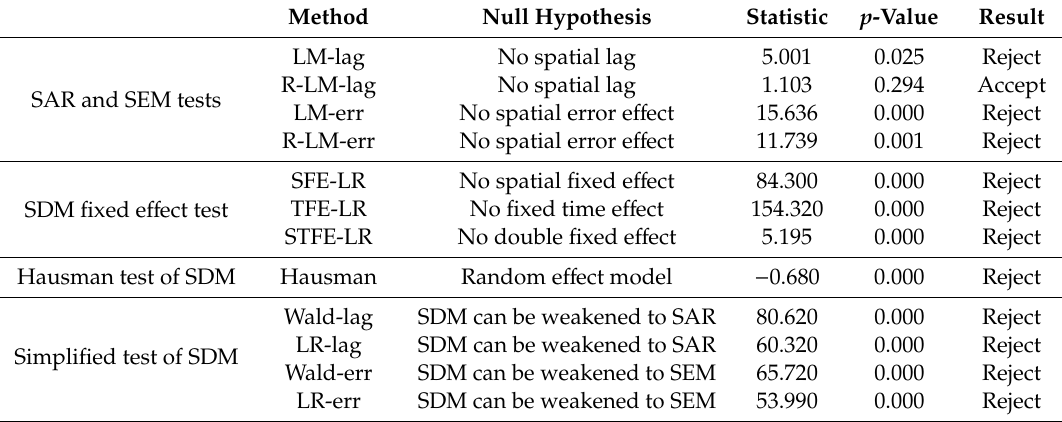
Table 7. Spatial panel data model test (GDP / SDE) under the geospatial matrix.